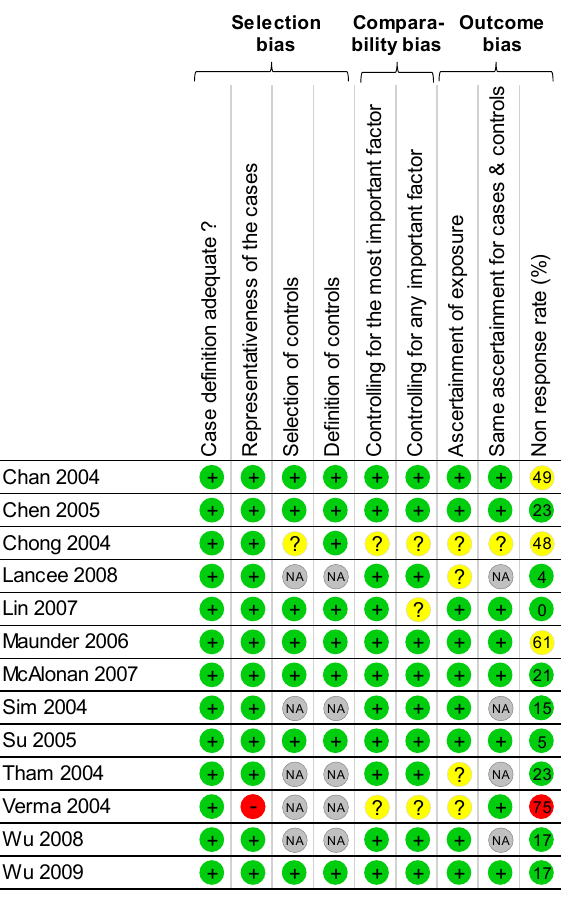
Figure A1. Quality of articles using the Newcastle–Ottawa scale (NOS). (N/A : Not applicable)